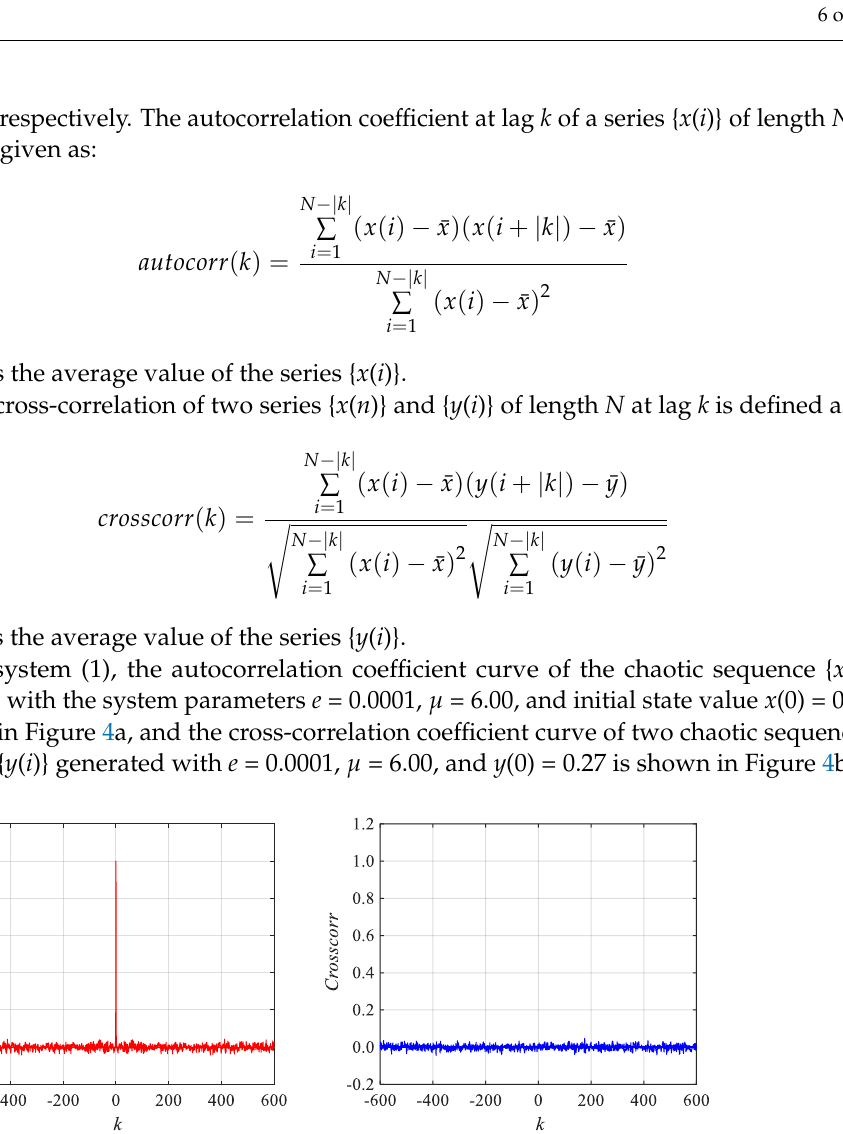
Figure 3. The time-series diagram and cobweb graph of system (1): ( a ) The time-series diagram, the blue dot data is generated from the initial value 0.23, and the red asterisk data is generated from the initial value 0.23+10 − 12 ; ( b ) the cobweb graph.